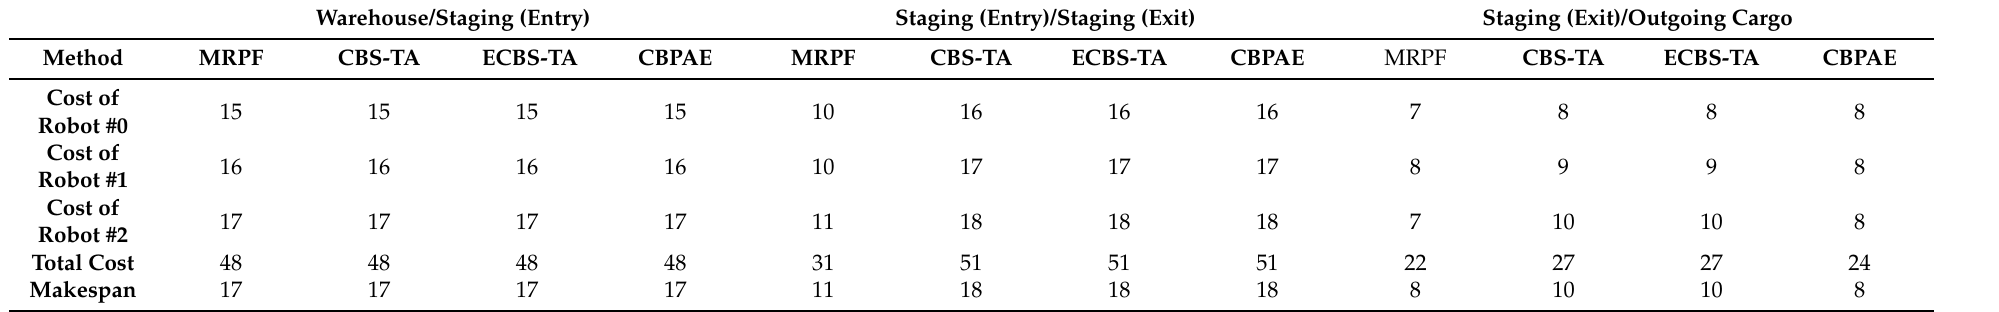
Table 10. Comparison of the MRPF approach with other works for the tasks of the Outgoing Cargo